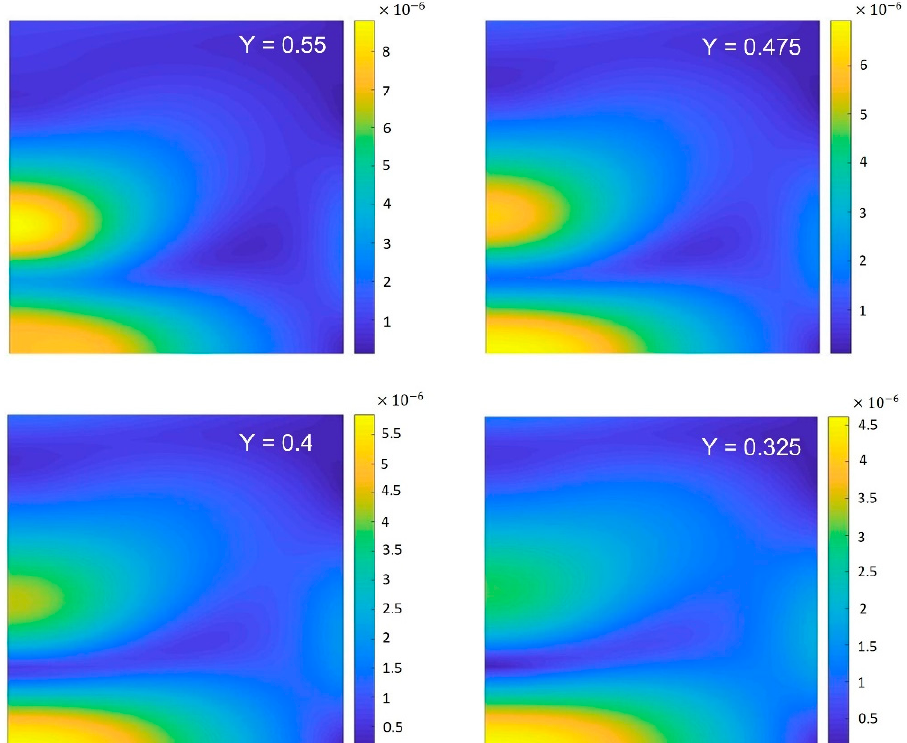
Figure 7. Change in magnitude of bidomain displacement, b , in progressively deeper planes of Y for the tissue with unequal anisotropy ratios (cid:4672) (cid:3082) (cid:3284) tissue. Tissue indentation occurs at Y = 1 surface. The fibers are horizontal.